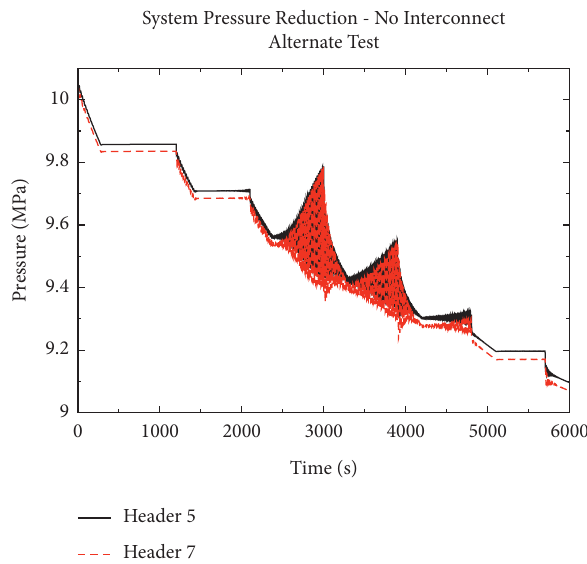
Figure 36: Flow oscillations resulting from system pressure reduction.